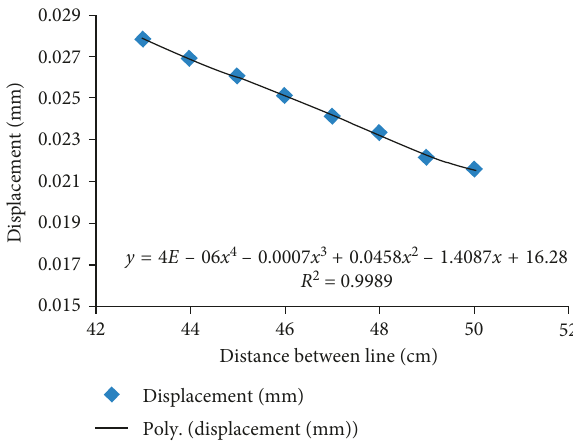
Figure 15: Maximum displacement as a function of the distance between the rows of holes in the square mesh.